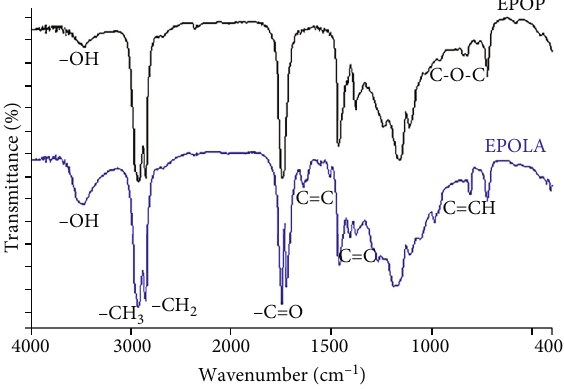
Figure 8: FTIR spectra of ELO and AELO (from Wuzella et al. [54],